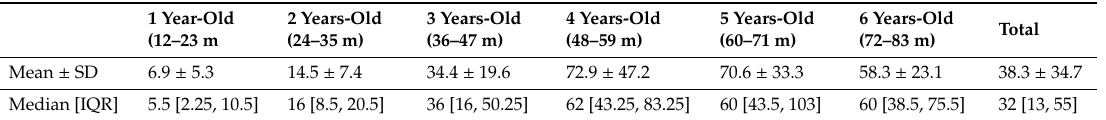
Table 1. Distribution of total melanocytic nevus counts by age in months (m) at baseline for n = 51 participants followed-up in